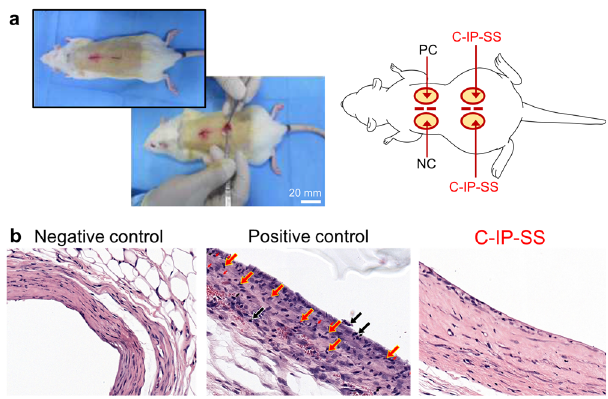
Fig. 7 Biocompatibility test of C-IP-SS. a Experimental procedure for in vivo histocompatibility testing: rat subcutaneous connective tissues with negative control (NC, HDPE), positive control (PC, DMSO-containing polyurethane), and the C-IP-SS fi lm. b Representative histopathologic tissue images after 12 weeks of healing. Arrows indicate in fl ammatory cells (red: polymorphonuclear cells; black: